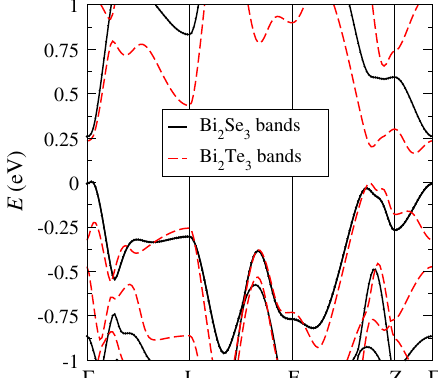
FIG. 1. The calculated band structure for Bi 2 Se 3 and Bi 2 Te 3 in the rhombohedral Brillouin zone. The valence band maximum is set to the energy